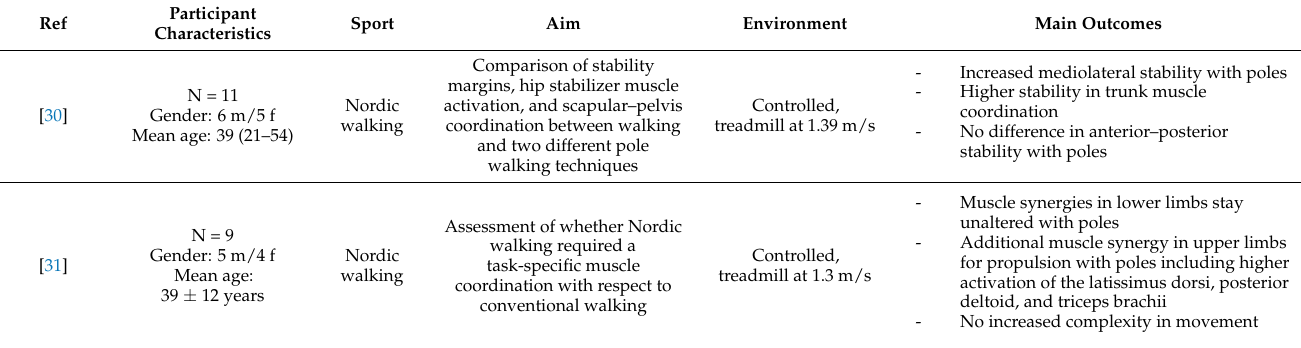
Table 3. Coordinative aspects of pole use.